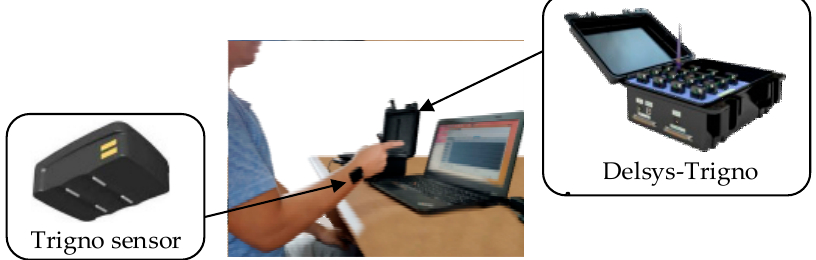
Figure 3. Schematic diagram of the data acquisition system.